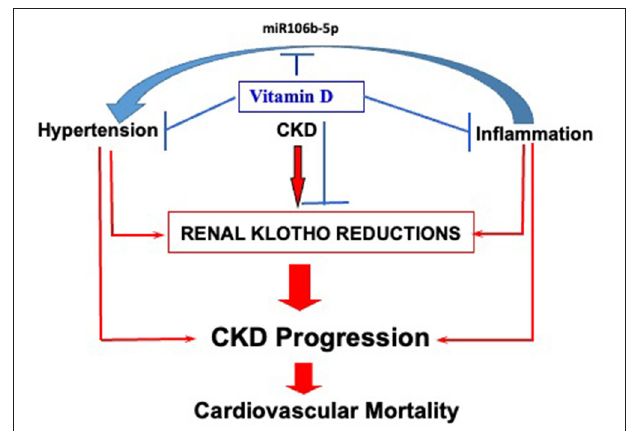
FIGURE 4 | Integration of non-classical vitamin D actions conferring renoprotection. Vitamin D protects against CKD progression through direct inhibition of systemic inflammation, hypertension and renal klotho reductions; indirect attenuation of the reductions in renal klotho content through the control of its most potent downregulators, systemic inflammation and hypertension; inhibition of the release of miR106b-5p by pro-inflammatory monocyte-macrophages, a novel link between inflammation with renin-dependent